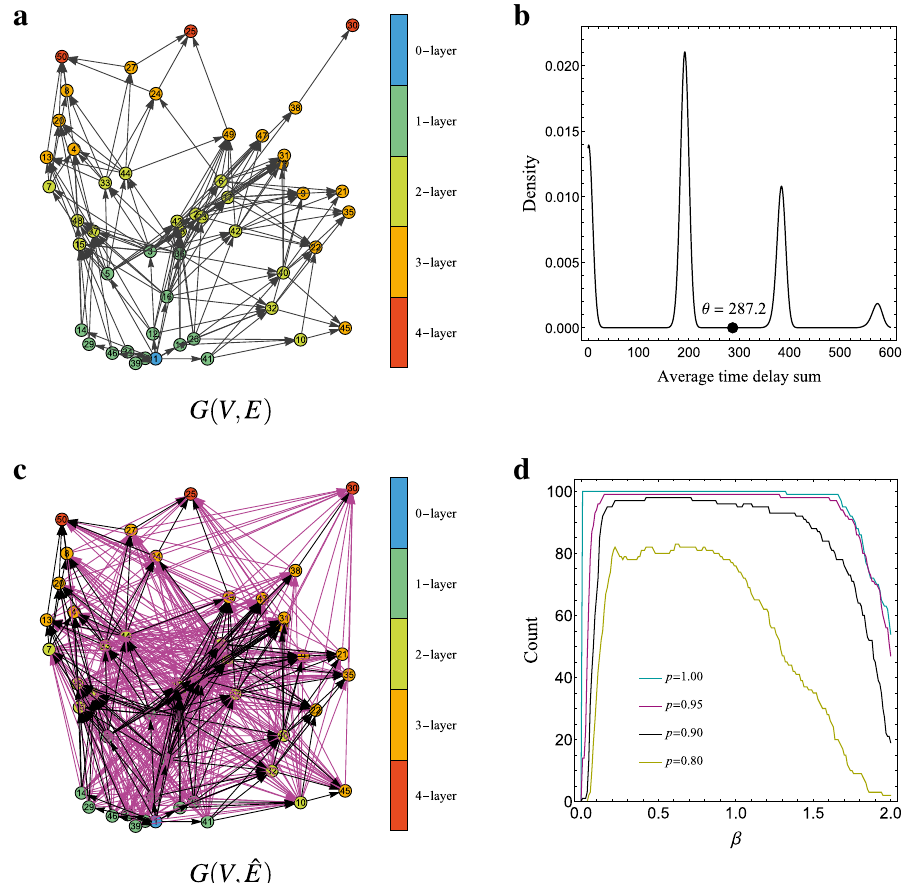
Figure 3. ( a ) The ground truth graph G ( V , E ) in the experiment of binary state propagation using one of the synthetic datasets with p = 0.95 . ( b ) The probability density of average time delay sum estimated by kernel density estimation for the dataset. The black circle ( θ = 287.2 ) indicates a threshold value adopted by our method. ( c ) The estimated graph G ( V , ˆ E ) by the proposed method for the dataset. Each individual i is located at r i . In G ( V , ˆ E ) , black arrows are edges in E and magenta arrows are edges in ˆ E \ E . Note that ˆ E includes E (recall 1.0) for this dataset. Each individual’s color indicates its belonging layer: blue, green, yellow, orange and red ˆ E ˆ E ˆ E ˆ E ˆ E individuals belong to V 0 , V 3 , and V 1 , V 2 , V 4 , respectively. ( d ) The number of datasets in which parameter β of the bandwidth achieves the minimum